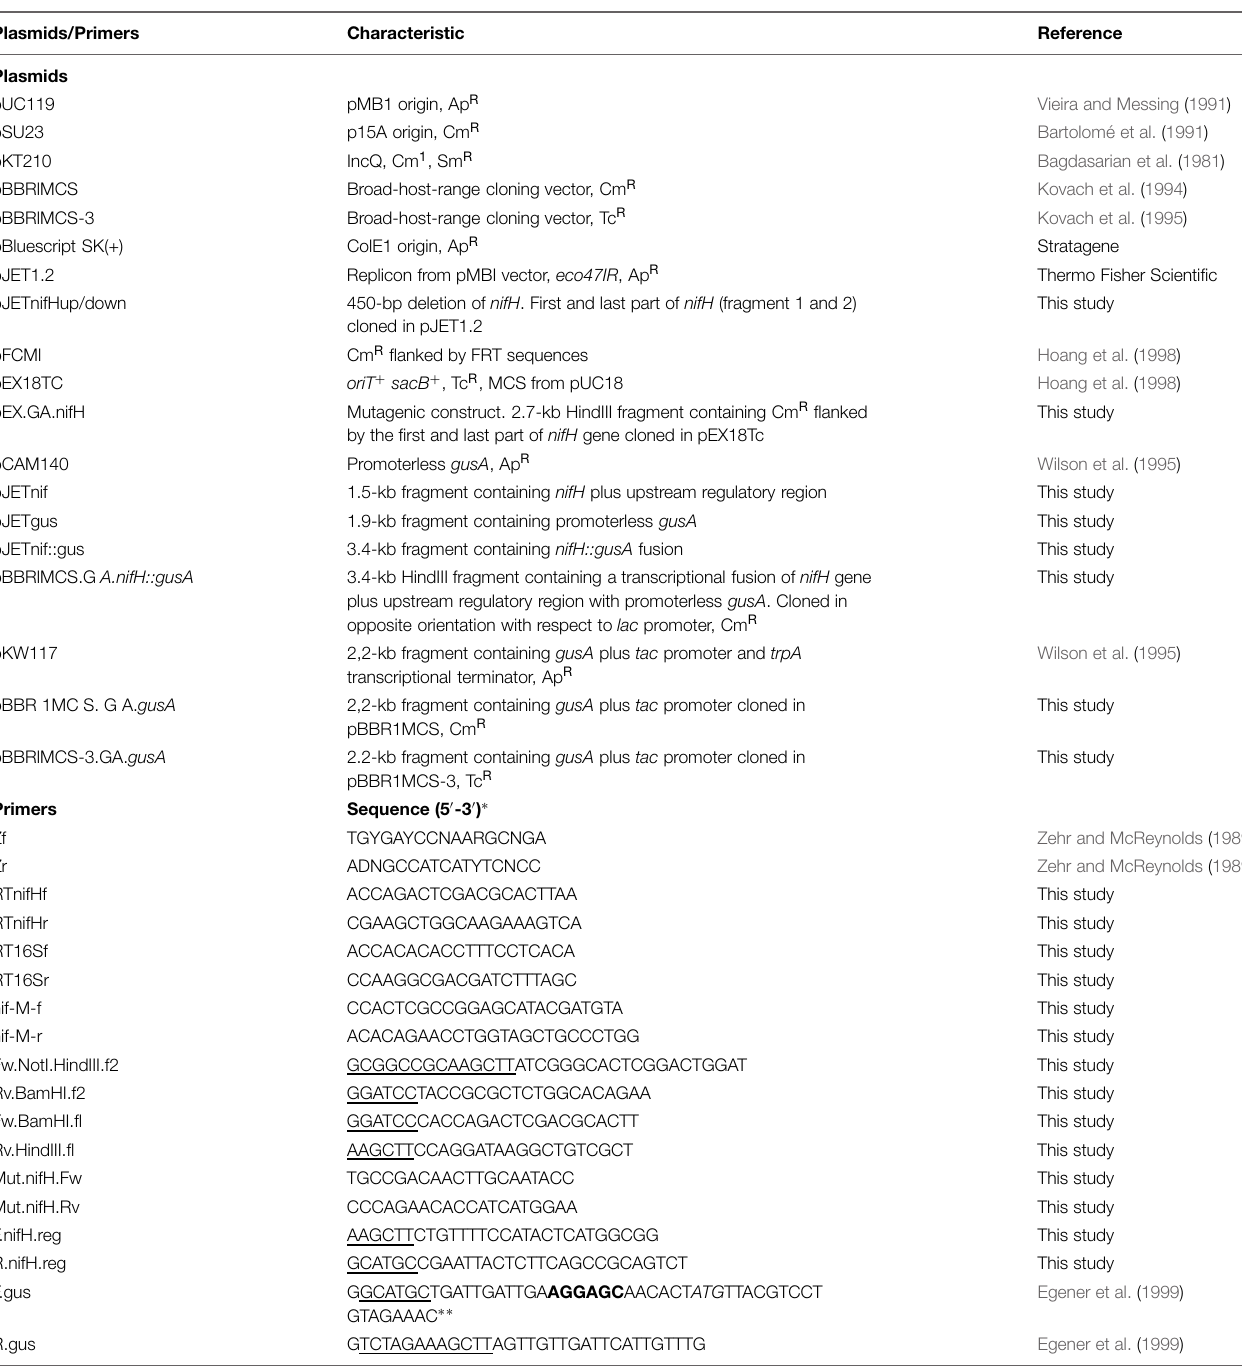
TABLE 2 | Plasmids and primers